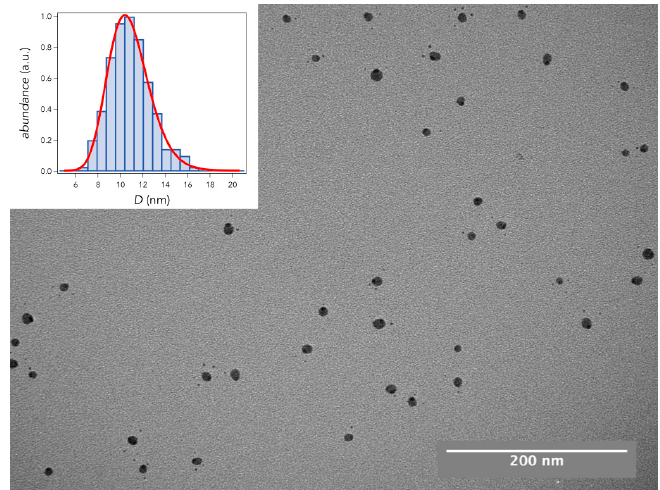
Figure 2. TEM image of Ag clusters deposited on a lacey carbon transmission grid. The inset shows the size distribution of the deposited